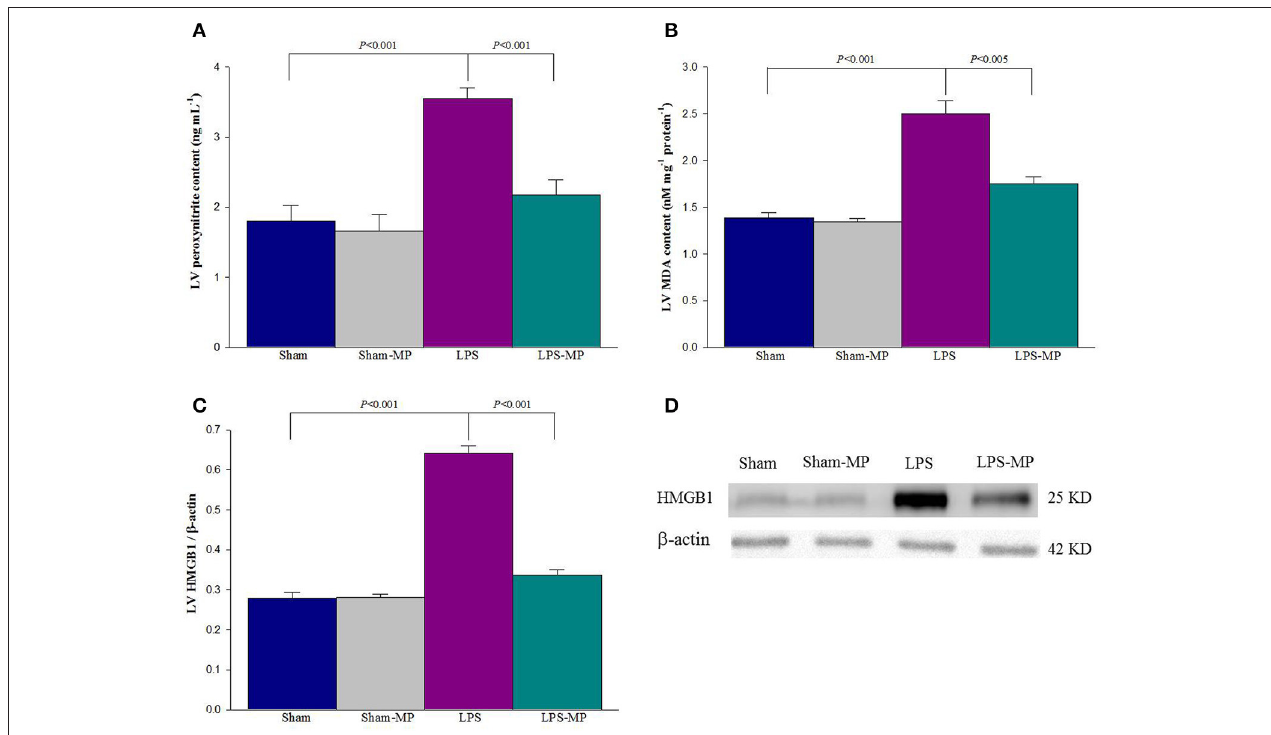
FIGURE 4 | Effects of LPS and MP on cardiac peroxynitrite (A), MDA (B), and HMGB1 (C) levels. Graph (D) shows the SDS-PAGE profiles of LV HMGB1, which were electrotransferred onto PVDF membranes by using an anti-HMGB1 antibody. Using β -actin expression as a referred base, the expression of protein was normalized to calculate the LV HMGB1 content. Cardiac peroxynitrite level was measured using commercially available enzyme-linked immunosorbent assay kits. LV MDA levels were estimated by TBARS by using a commercial kit. Results are expressed as the mean ± s.e. LPS, lipopolysaccharide; LV, left ventricular; MP, methylprednisolone; HMGB1, high mobility group box 1; MDA, malondialdehyde ( n = 10